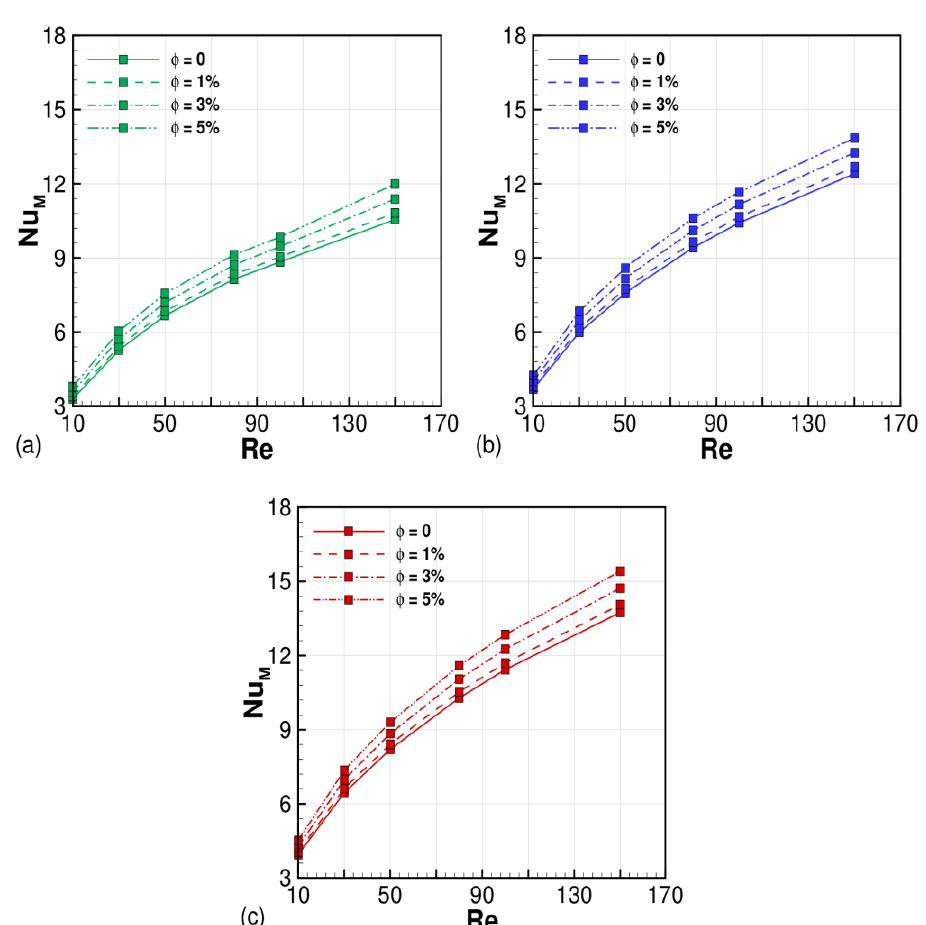
Figure 14. Mean Nusselt number ( 𝑁𝑢 𝑀 ) as a function of Re for different values of φ at Ri ; ( a ) 0, ( b ) 0.5, and ( c ) 1. Table 3. Comparison of drag coefficient ( 𝐶 𝐷 ) and Nusselt number ( 𝑁𝑢 𝑀 ) of the cylinder with the literature.